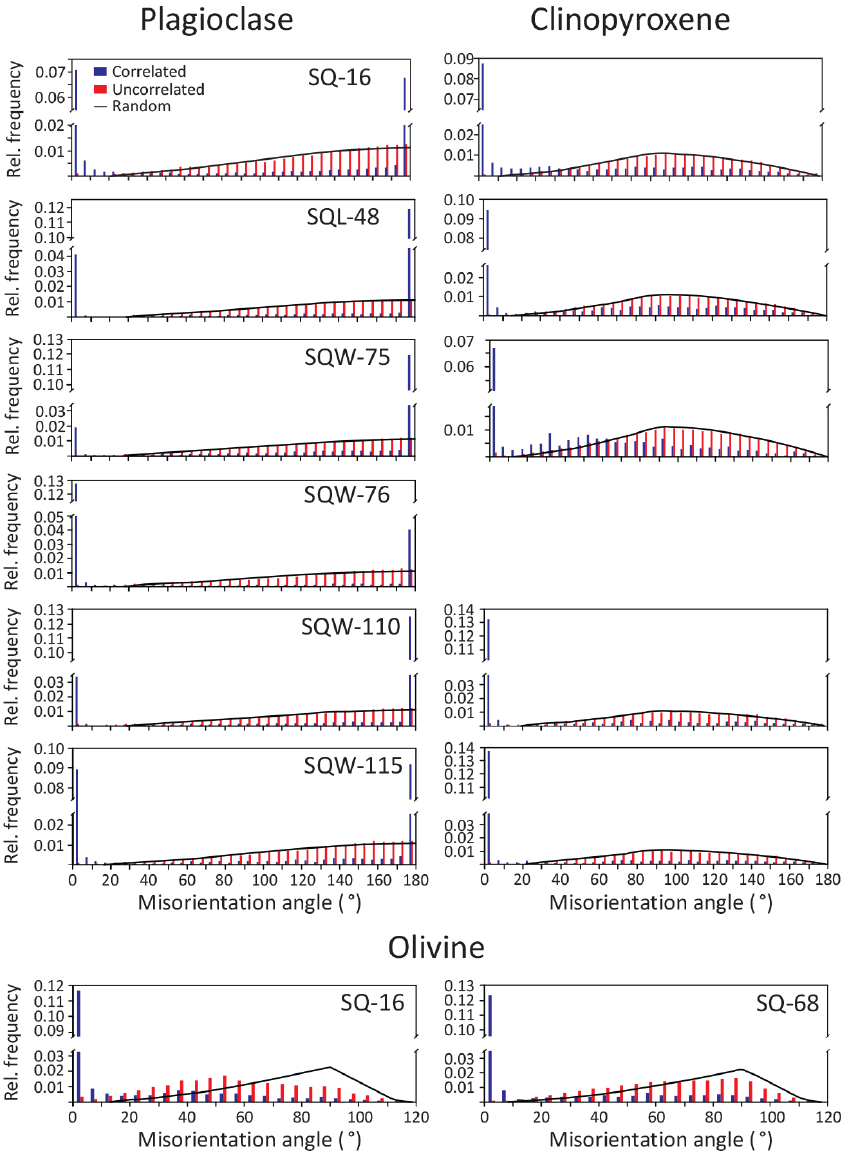
Figure 11. Histograms of misorientation angles for the correlated and uncorrelated distributions of plagioclase, clinopyroxene, and